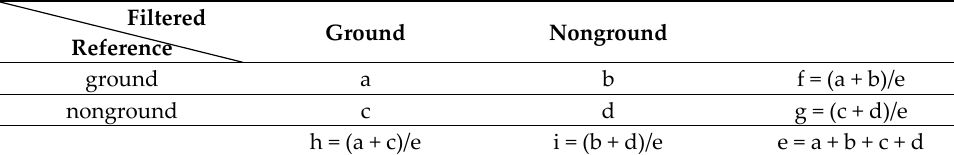
Table 3. The initial grid resolution and residual threshold used in the ASI